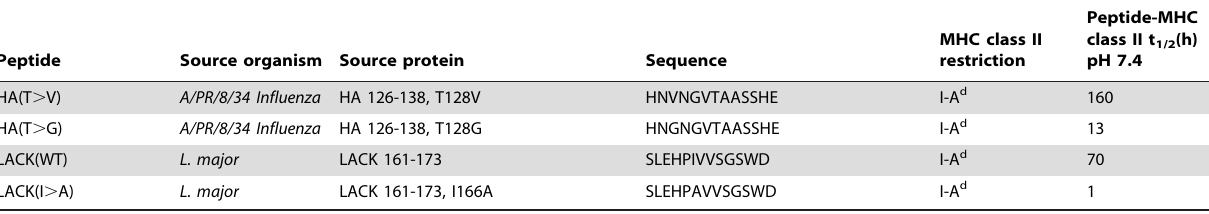
Shown are the kinetic stability peptide variants from hemagglutinin (HA) and Leishmanina antigen protein kinase (LACK) evaluated in Figure 9.